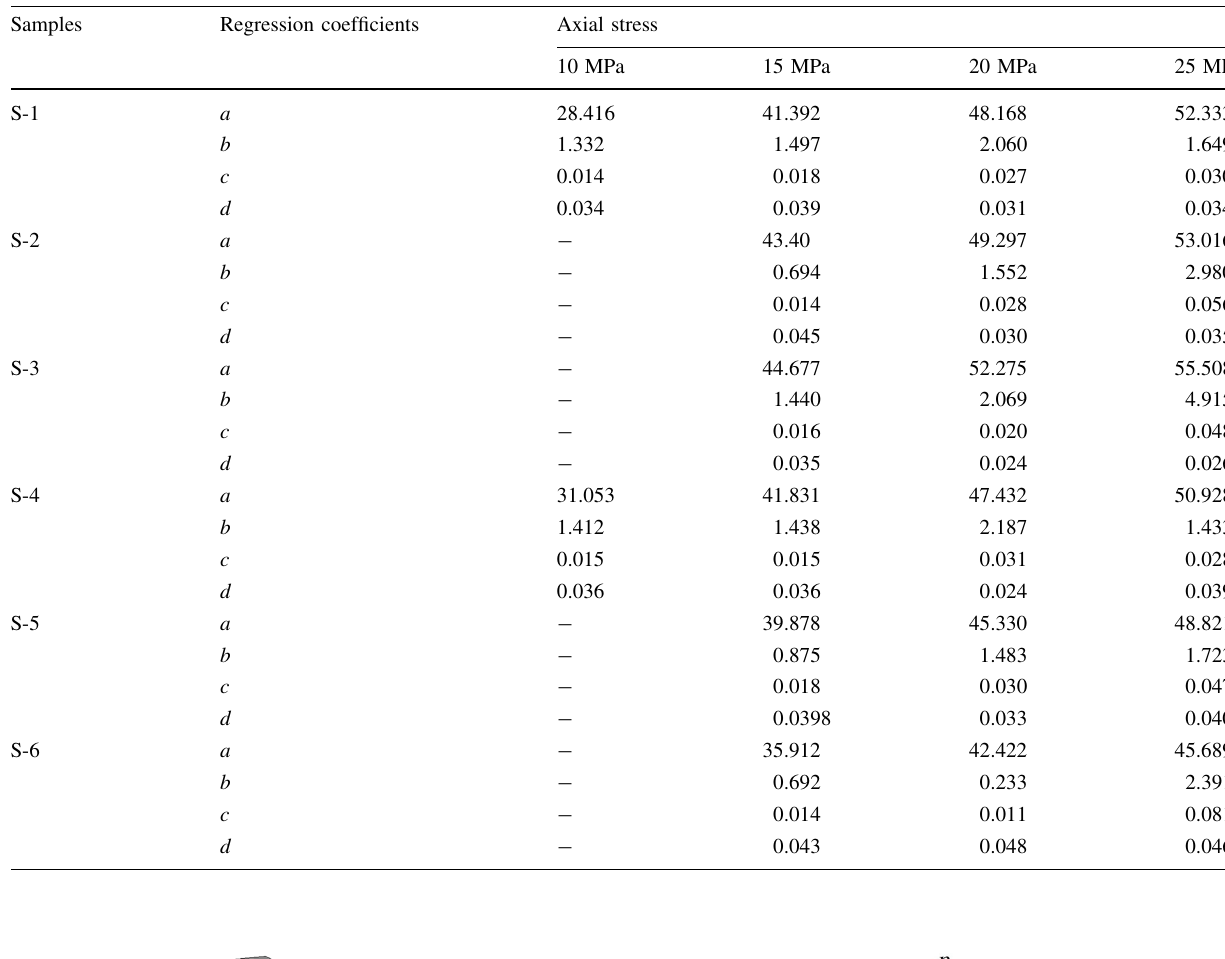
Table 3 Regression coefficients of the fitting curves for the crushed samples under different axial stresses Samples